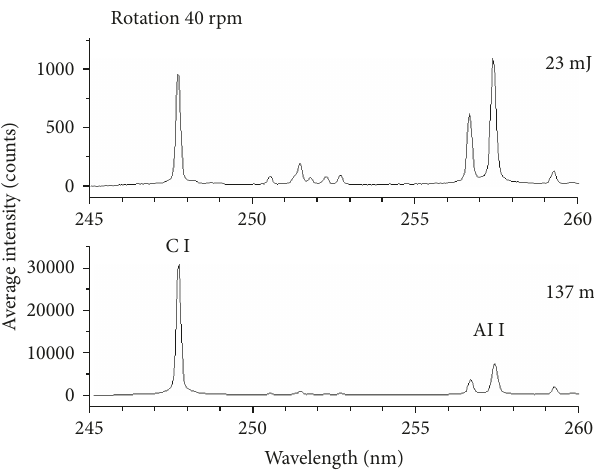
Figure 8: LIBS spectra from peanut oil on aluminum substrate (polishing 400grits/mm) averaged over 10 laser pulses with energies of 23 mJ (top) and 137mJ (bottom); the rotation speed is